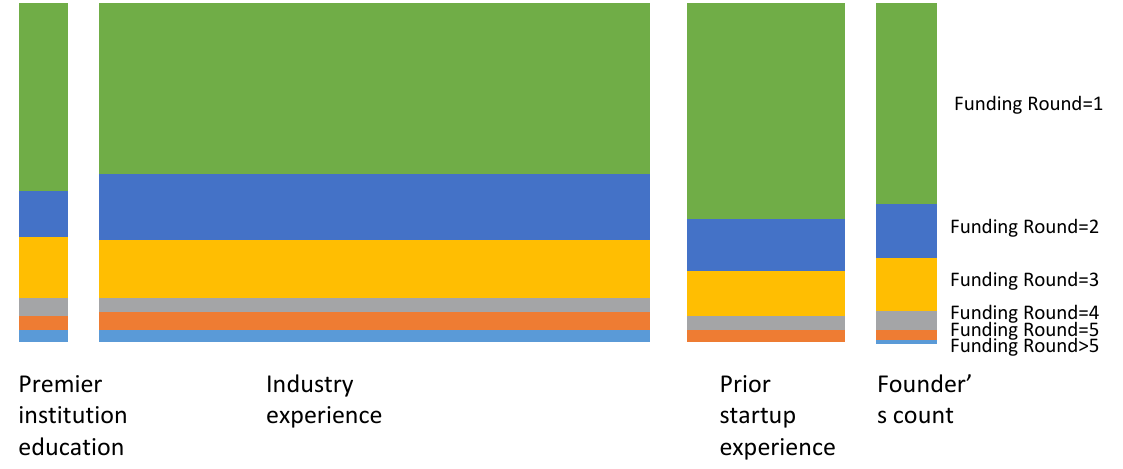
Figure 3. Mosaic plot showing relationships between number of funding rounds and human capital variables